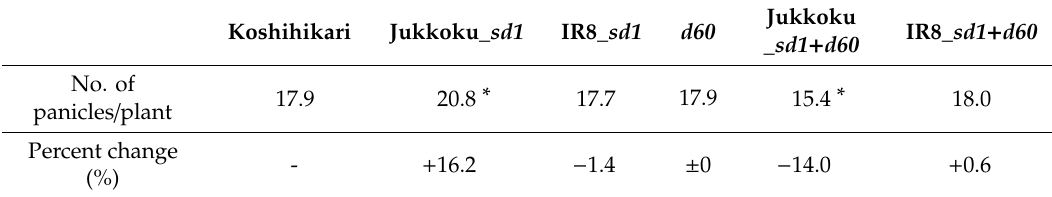
Figure4. No. ofpanicles / plantinsemidwarfanddoubledwarfgenelines. Thenumberofpanicles / plants Figure 4. No. of panicles/plant in semidwarf and double dwarf gene lines. The number of was highest at 20.8 in line carrying Jukkoku_ sd1 ( + 10.2% vs Koshihikari). panicles/plants was highest at 20.8 in line carrying Jukkoku _sd1 (+10.2% vs Koshihikari). Table 3. E ff ect of semidwarf and double dwarf genes to No. of panicles / Table 3. Effect of semidwarf and double dwarf genes to No. of panicles/plant.